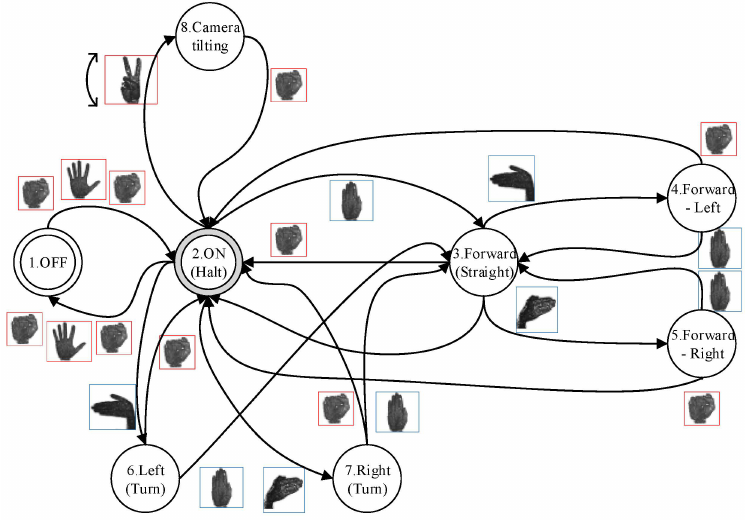
Figure 16. Navigation through a finite-state machine by means of triggering gestures.